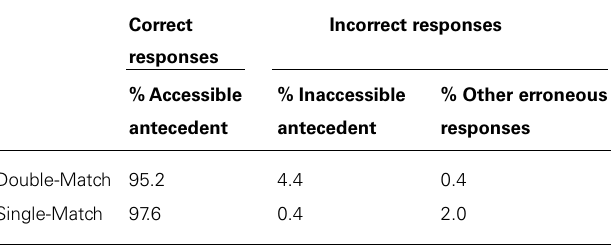
Table 1 | Offline button press responses.